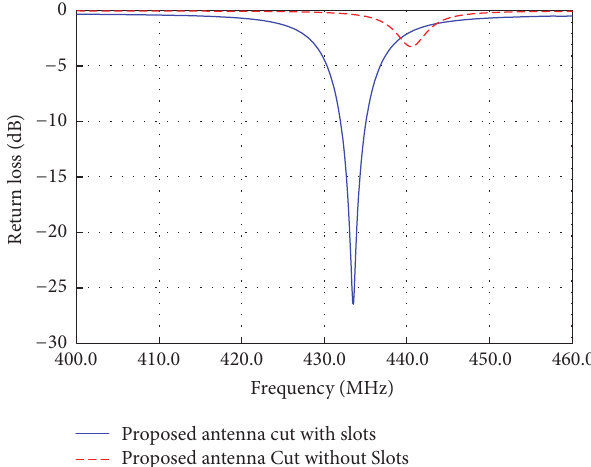
Proposed antenna cut with slots Proposed antenna Cut without Figure 8: Simulated return loss of the proposed antenna cut with and without